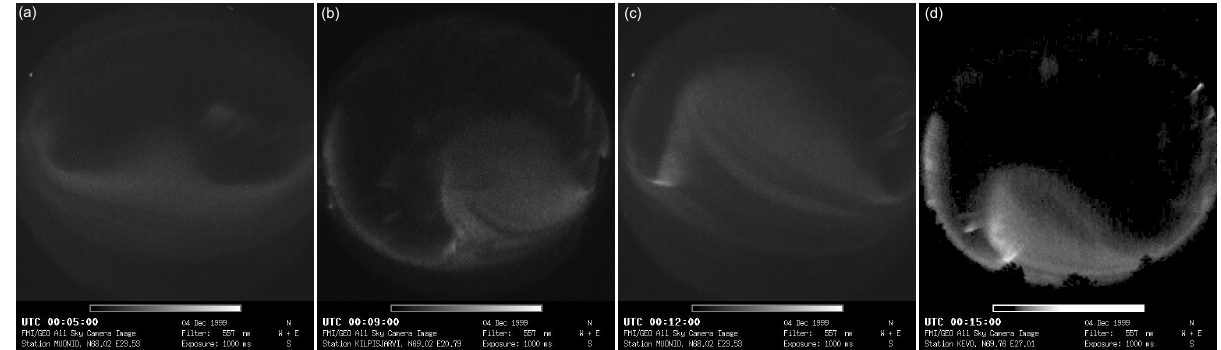
Figure 10. Auroral omega forms observed at MUO at 00:05UT, KIL at 00:09UT, MUO at 00:12UT and KEV at 00:15UT. The first image at 00:05UT shows the first observed omega form and the last three images capture the second individual omega structure at different stations. The contrast in all images has been enhanced.